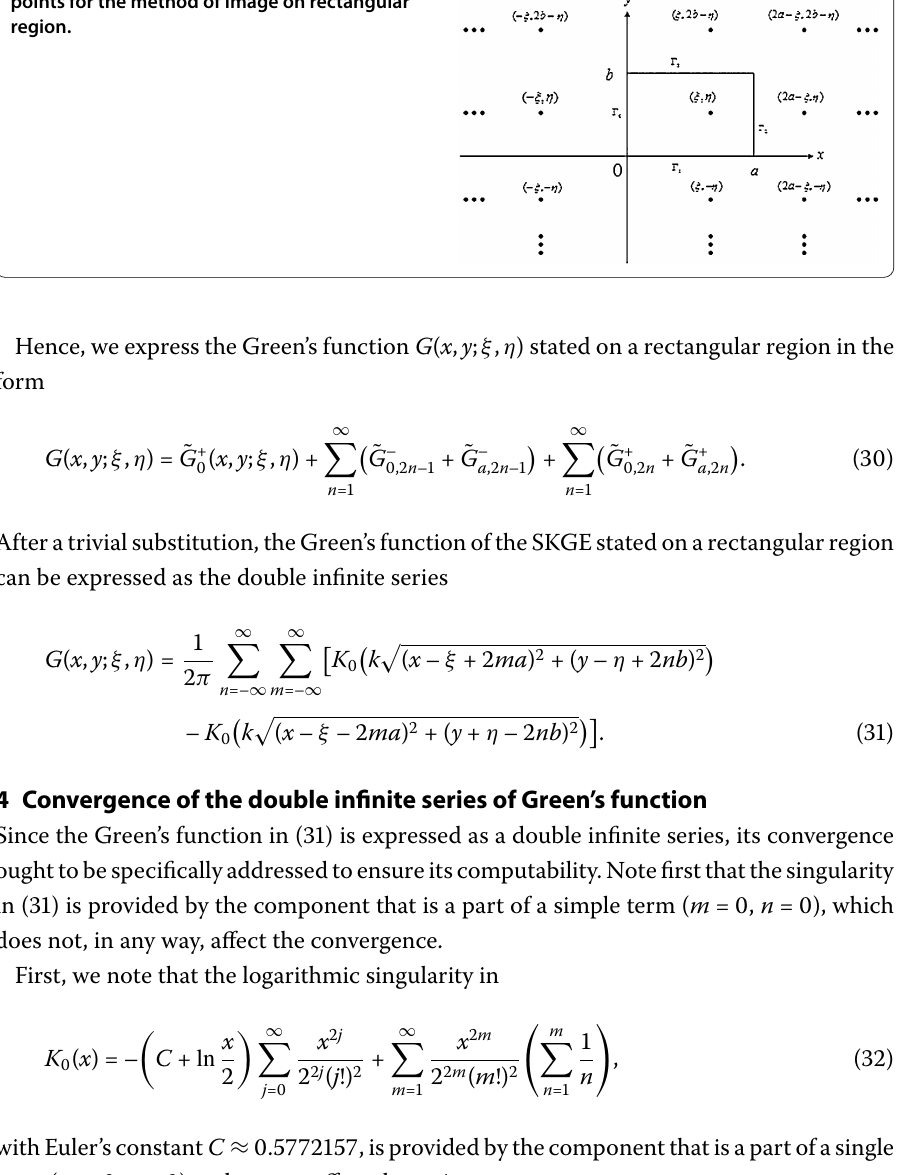
Figure 2 Display of symmetric compensating points for the method of image on rectangular